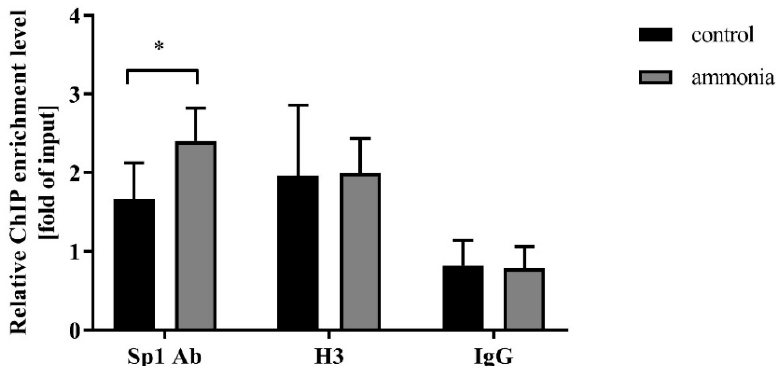
Figure 2. Sp1 transcription factor binding to the Snat3 promoter region (Sp1 Ab) in mouse astrocytes treated with 5 mM ammonia for 24 h. Histone H3 was used as a positive control and IgG was used as a negative control of Sp1 binding to the Snat3 promoter region. Results are mean ± SD ( n = 4). (*) p < 0.05 vs. control; Two-way ANOVA and Bonferroni post-hoc test.